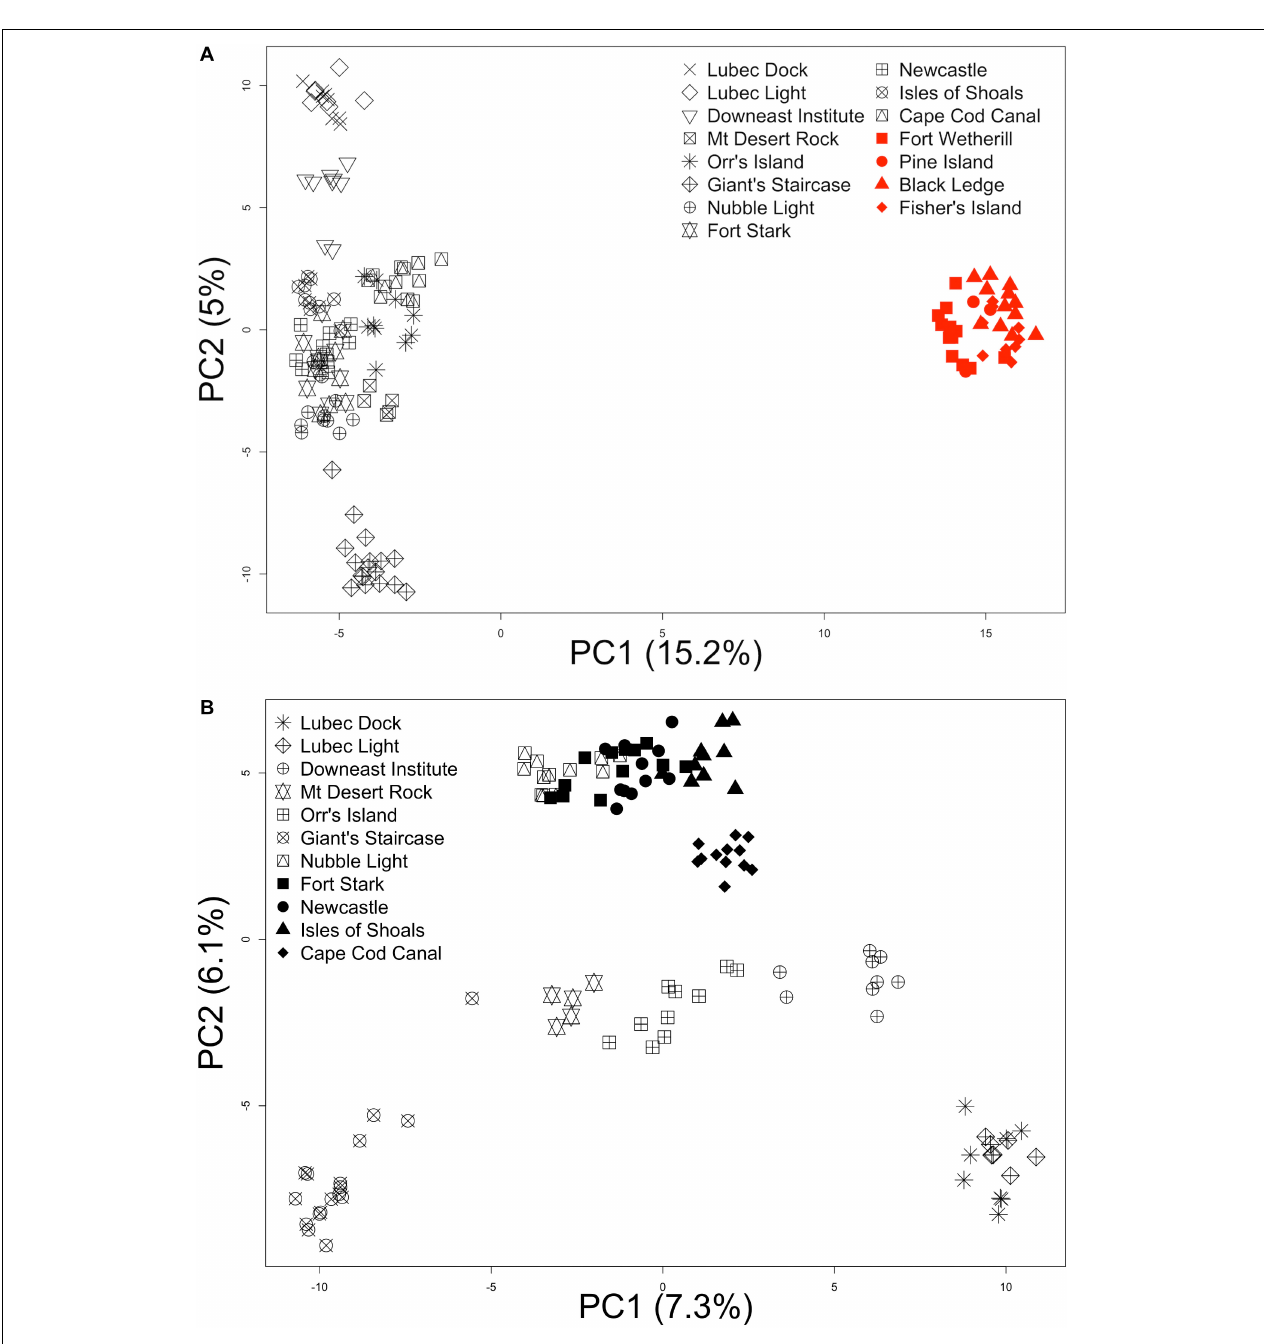
FIGURE 4 | Principal coordinate analysis (PCoA). Samples are labeled according to their collection locations. The two PCs that explain most of the variation are shown in the plots. (A) PCoA of 149 samples from all 15 locations; (B) PCoA of 113 samples from GOM (Gulf of Maine) only.